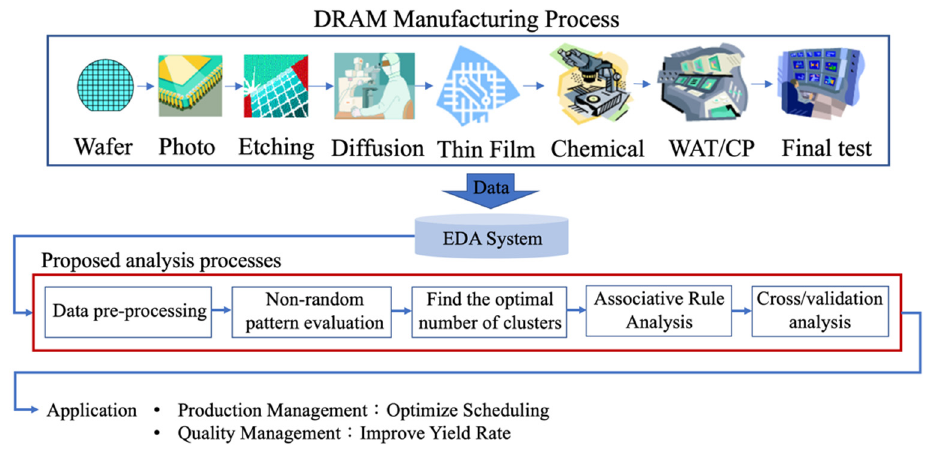
Figure 1. The analysis framework flowchart.